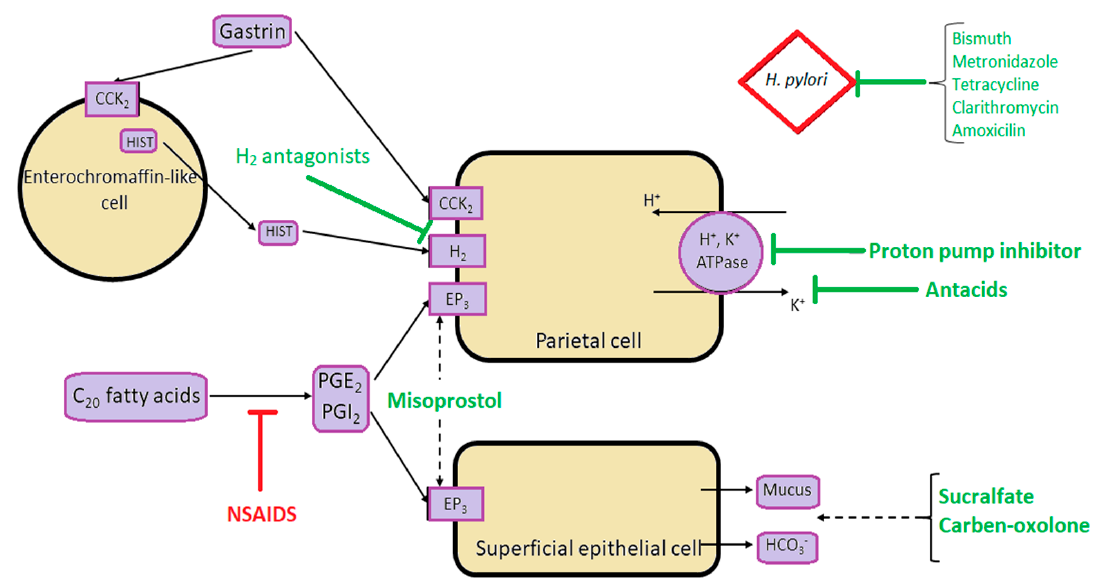
Figure 1. Schematic presentation of main pathophysiological mechanisms involved in the development of peptic ulcer disease, and the sites of action of the most commonly used pharmacological options in the treatment of peptic ulcer disease. CCK 2 = Cholecystokinin Receptor; PGE 2 = Prostaglandin E 2 ; PGI 2 = Prostaglandin I 2 ; EP 3 = Prostaglandin E receptor 3; HIST = Histamine.